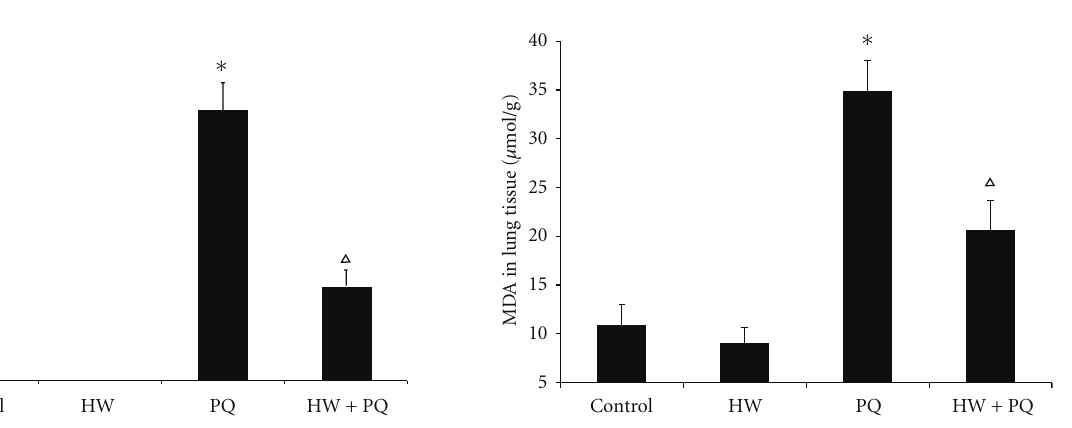
Figure 1: E ff ects of hydrogen water on pleural e ff usion. The rats in PQ group exhibited an increase in the volume of pleural e ff usion at the end of 72h, whereas in PQ + HW group this increase was significantly smaller ( ∗ P < . 01 compared to control; (cid:2) P < . 01 compared to PQ group).